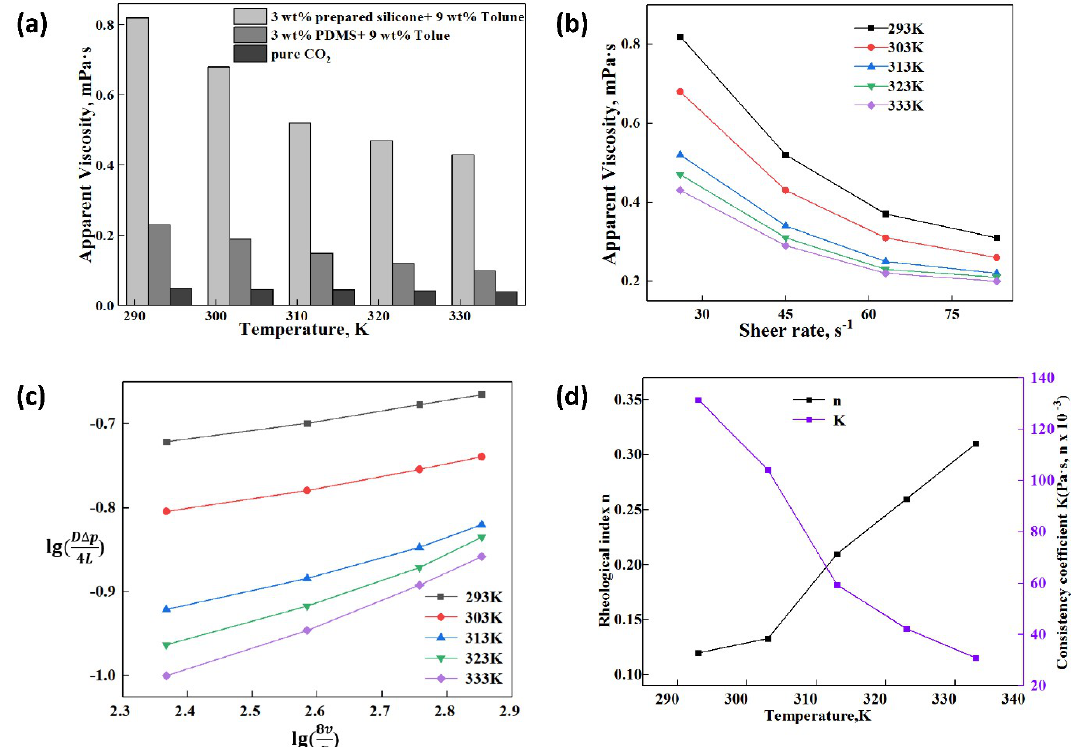
Figure 4. Effect of temperature on the apparent viscosity and rheology; ( a ) Temperature and apparent viscosity; ( b ) Shear rate and apparent viscosity; ( c ) Log τ w and Log(8 v / D ); ( d ) Rheological index, consistency coefficient and